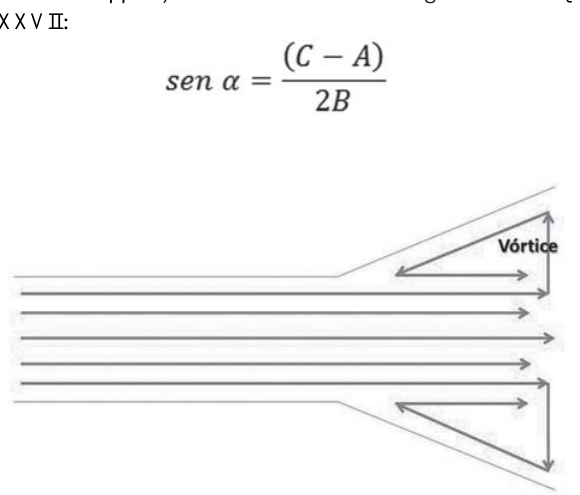
Fig. 8 - Diagrama esquemático fluxo dentro de um aneurisma, com a formação de vórtice